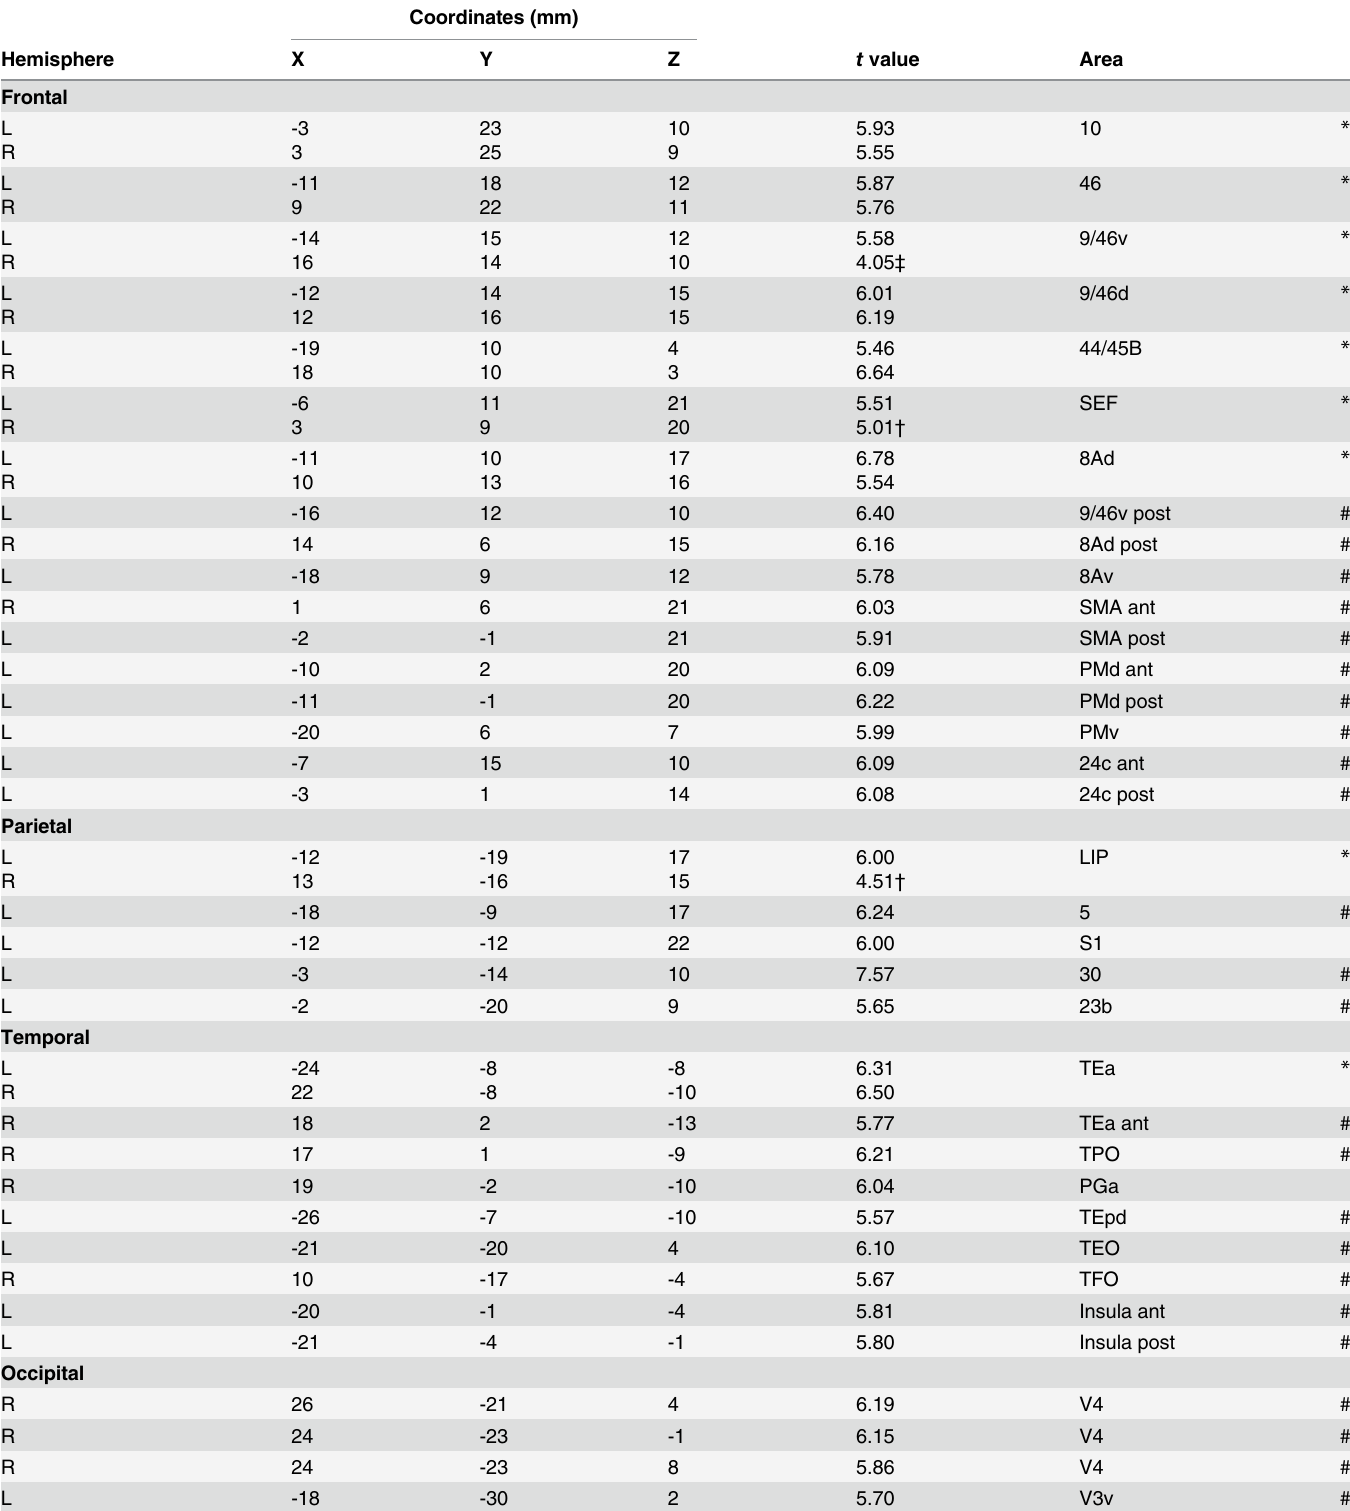
Table 1. Brain regions activated in MIDDLE minus BOTH-END contrast.